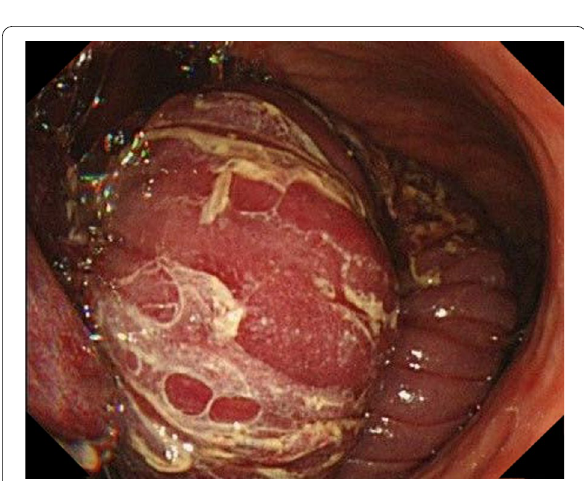
Fig. 2 Gastroscopy revealed intussusception of the intestine into the stomach